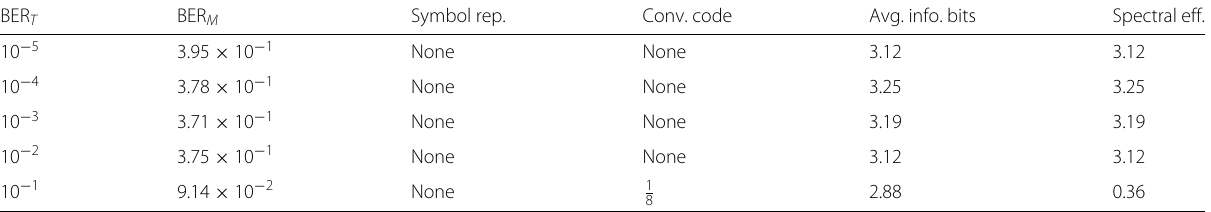
Table 3 The results from the simulated annealing optimization without using the PMW and PFD approach BER T BER M Symbol rep. Conv.